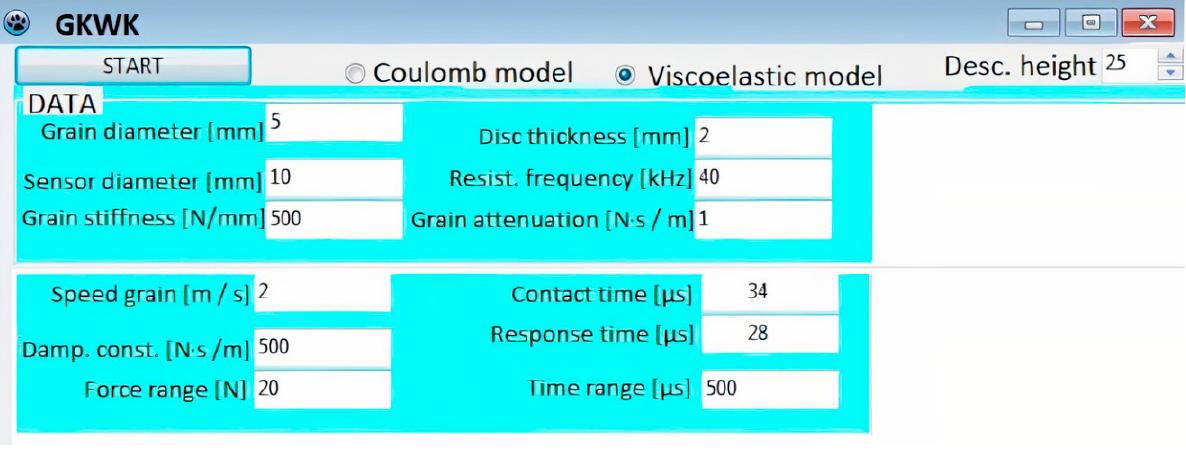
Figure 4. GKWK, Poznan, Poland, 2017, software interface view.